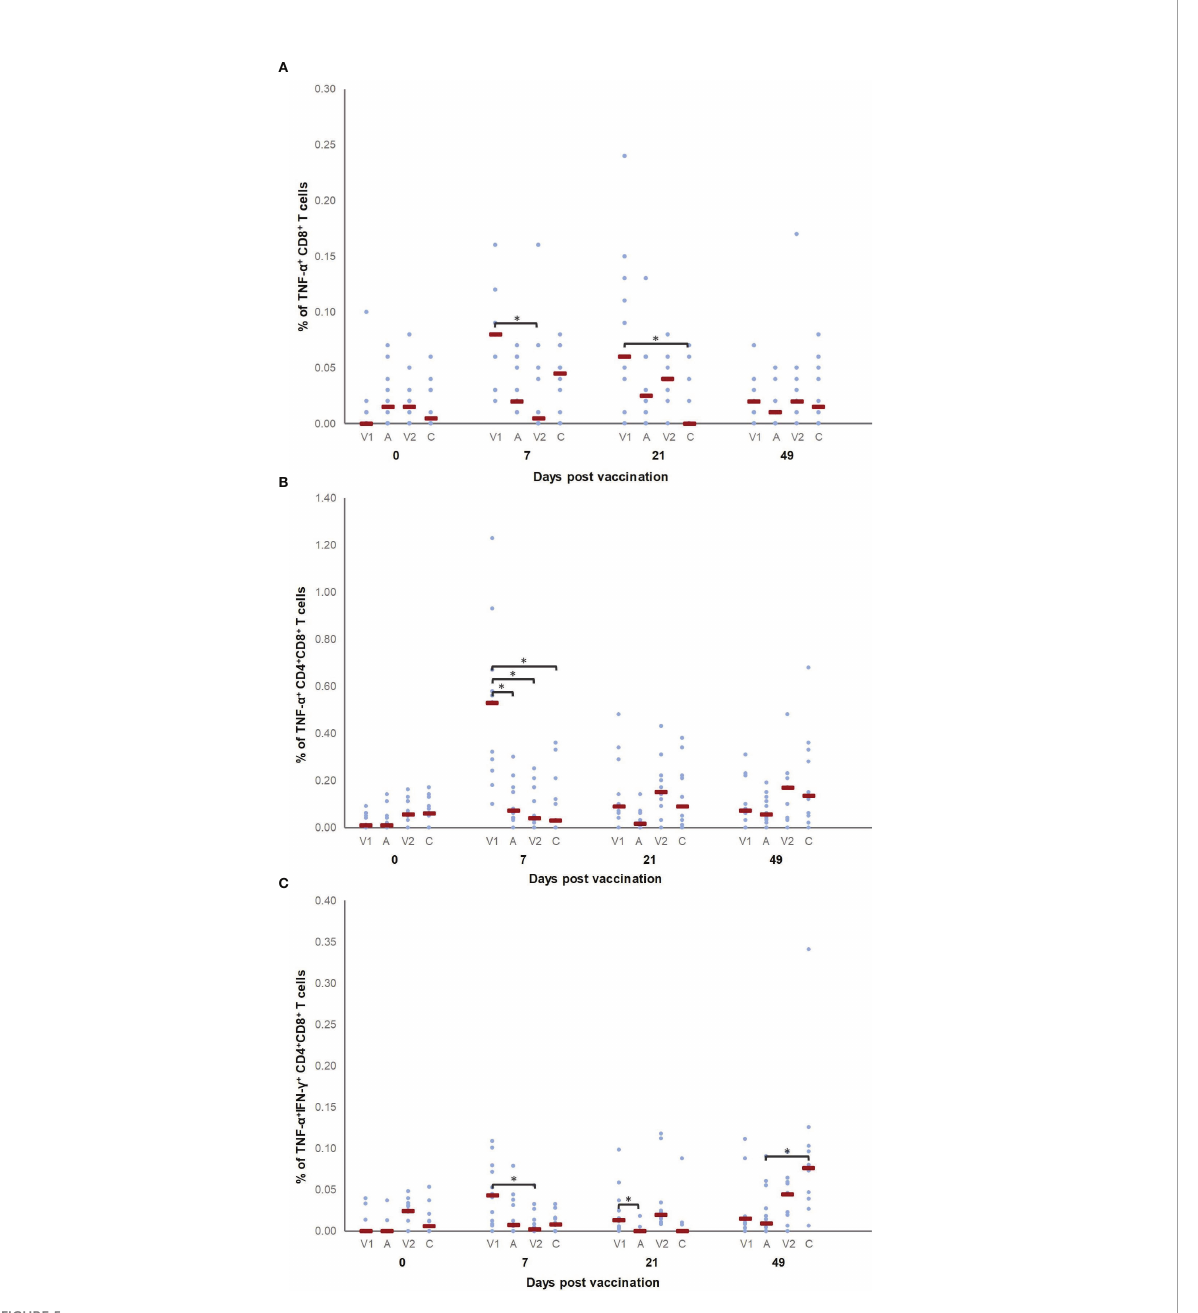
FIGURE 5 Percentage of M. hyopneumoniae − speci fi c cytokine-producing T cell subsets. Piglets were vaccinated on D0 with V1, A, V2 or physiological saline solution (C), and animals were challenge infected on D21 and euthanized on D49. The percentage of M. hyopneumoniae − speci fi c TNF- a + CD8 + (A) , TNF- a + CD4 + CD8 + (B) and TNF- a + IFN- g + CD4 + CD8 + (C) T cells was determined using a recall assay. First, for each time point, signi fi cant differences between groups were analyzed using a Kruskal – Wallis H-test with Dunn-Bonferroni post hoc test. Next, the effect of sampling time was evaluated within each group using a generalized estimating equation procedure with an identity link function, accounting for repeated measurements on a pig level in an exchangeable correlation matrix and using D0 as the reference category. Data are considered relevant if signi fi cant differences were observed between the groups on a speci fi c sampling day, and if there was a signi fi cant effect of sampling time for (at least) one of the groups on this sampling day. Statistical results were considered signi fi cant when p ≤ 0.05 (*). A signi fi cant difference was observed for D7 and D21 as compared to D0 in V1 for the percentage of TNF- a + CD8 + T cells, while the percentage of TNF- a + CD4 + CD8 + T cells was higher on D7 as compared to D0 in V1. Furthermore, the percentage of TNF- a + IFN- g + CD4 + CD8 + T cells was higher in V1 on D7 and D21 compared to D0, and in C on D49 compared to